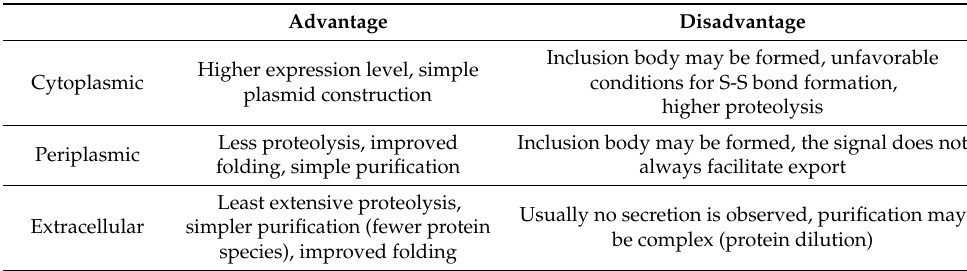
Table 4. Advantages and disadvantages of di ff erent locations of